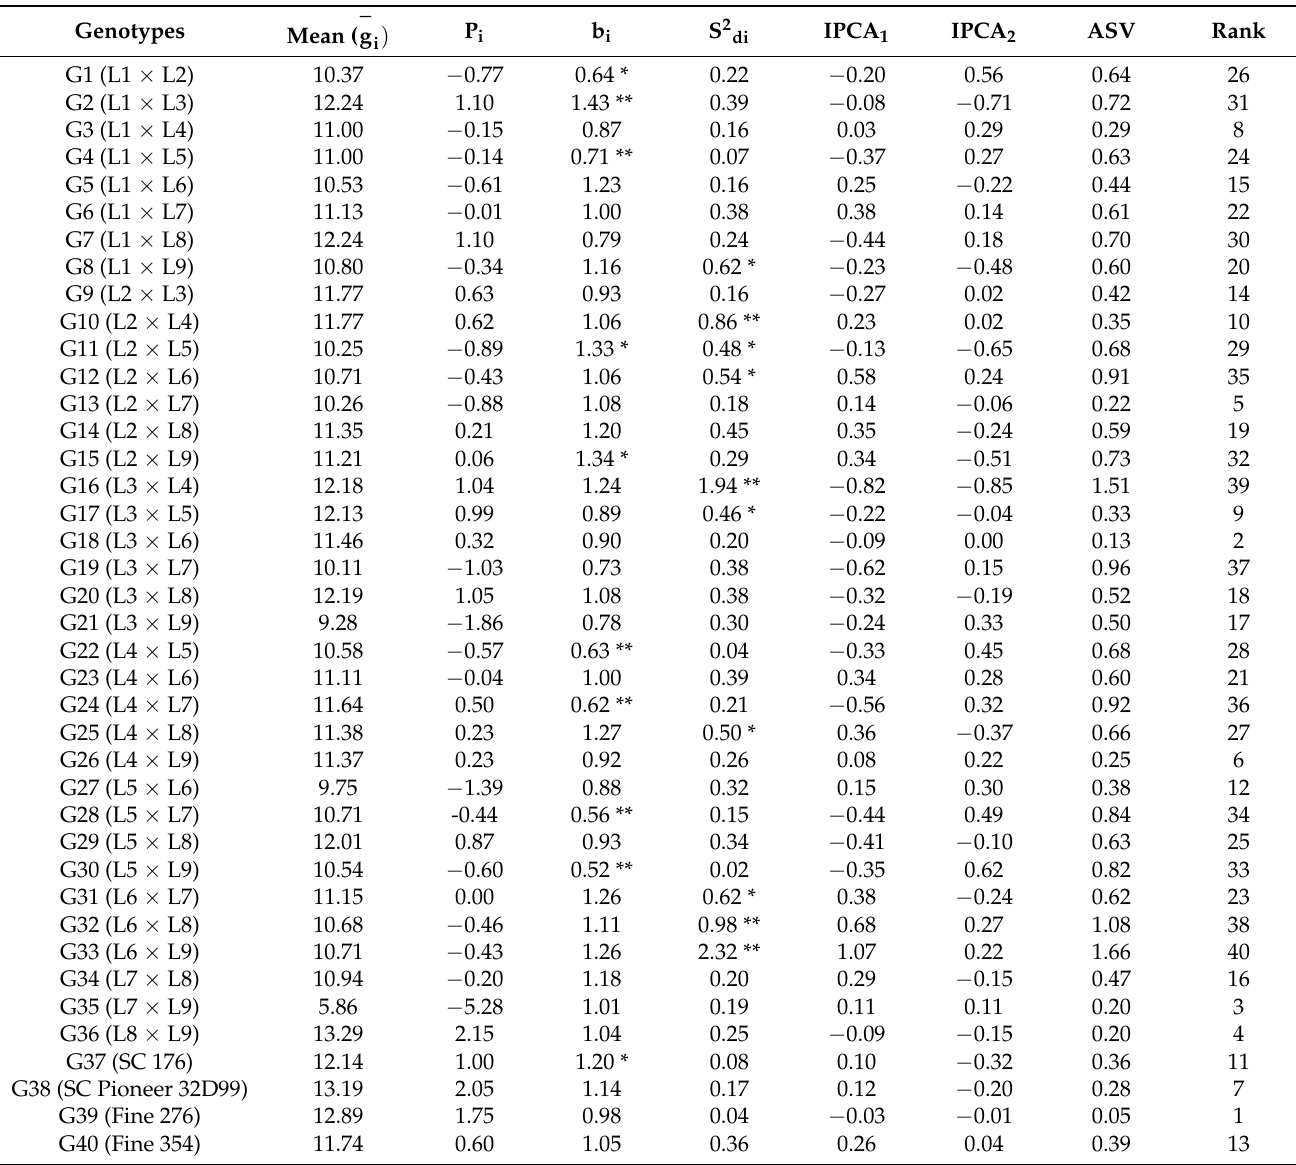
Table 6. Stability parameters of the evaluated 40 maize hybrids for grain yield (ton ha − 1 ) under two sowing dates and three plant